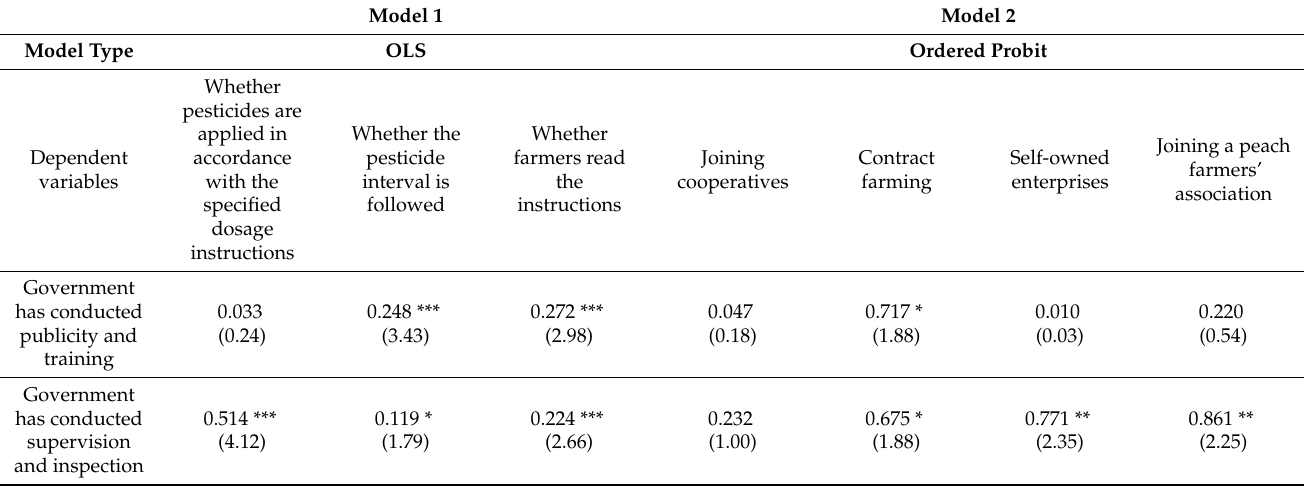
Table 4. Testing the mediation